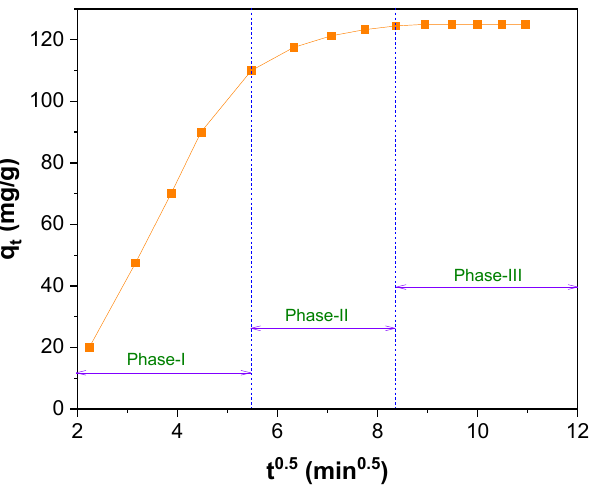
Figure 10. Weber ‐ Morris intraparticle diffusion plot for the Cd(II) adsorption over CNTs ‐ Ag 2 S.